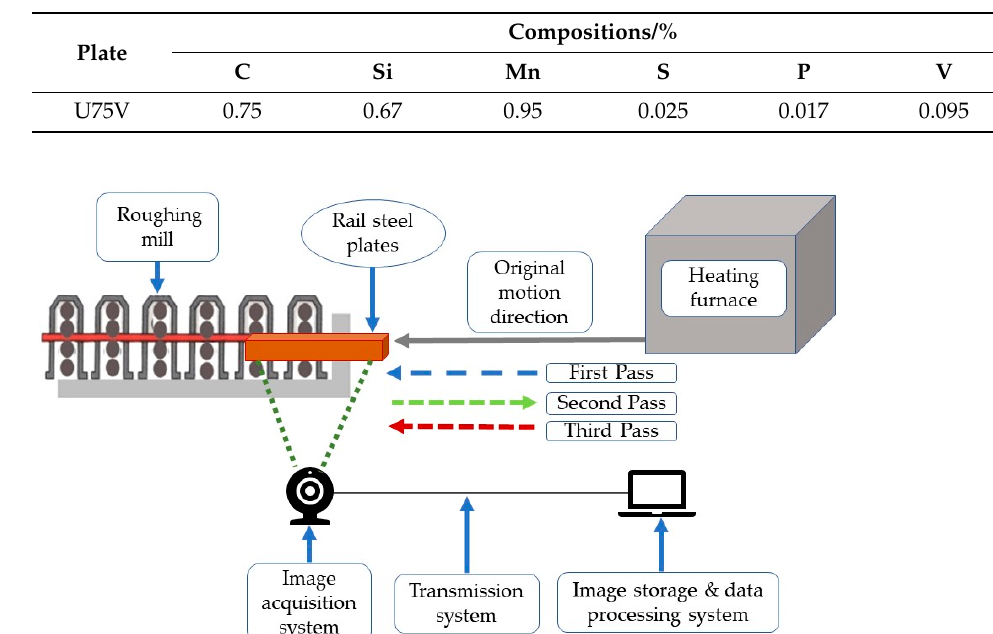
Figure 3. The diagram of the digital imaging system in the rail steel plates rolling process (online version in color).